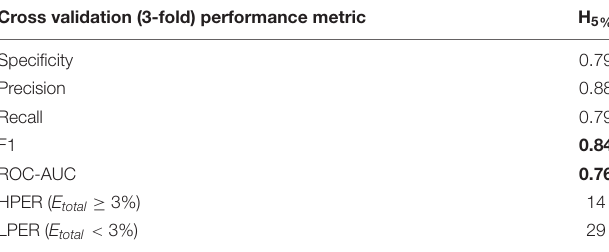
TABLE 3 | Comparing the performance error prediction using spectral entropy features vs. number of autocorrelation peaks. Cross validation (3-fold) performance